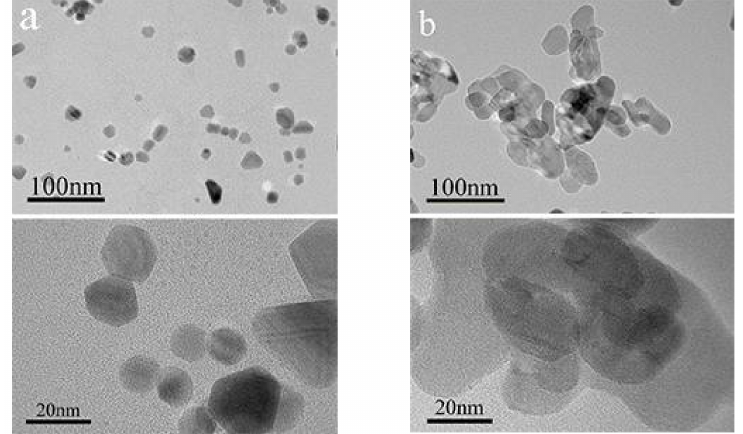
Figure 1. TEM images of ZnO NPs with honeysuckle extract added ( a ). TEM images of ZnO NPs without honeysuckle extract added ( b ).